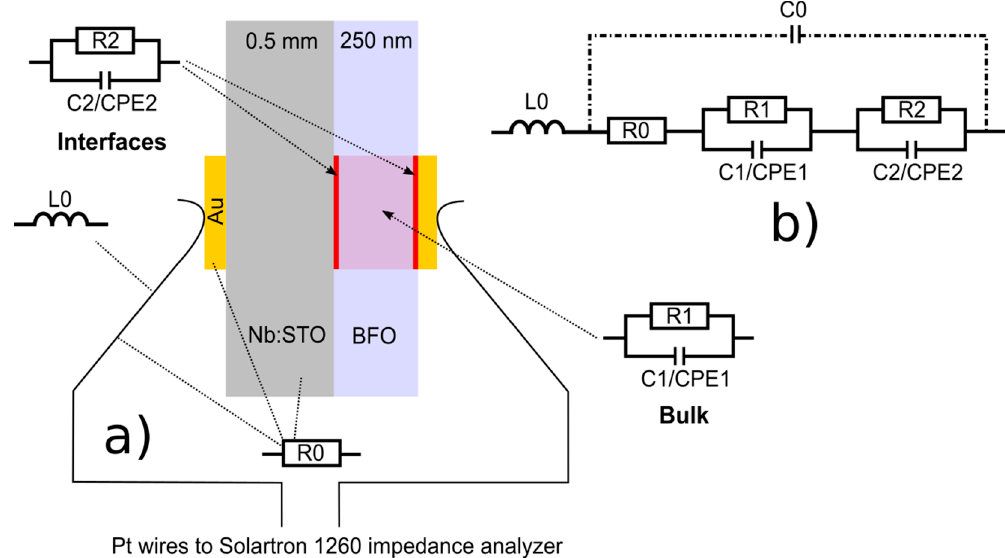
Figure 1. ( a ) Sample geometry for EIS measurements of BFO thin films in ‘through-plane’ geometry; ( b ) equivalent circuit model used for data fitting.